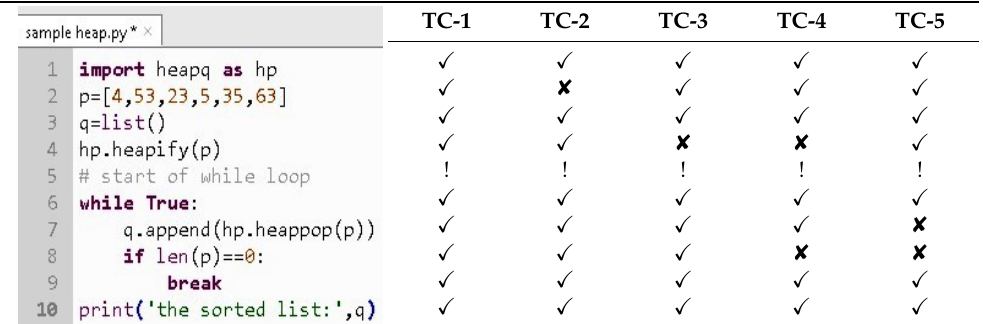
Table 3. Table representing the code snippet with the outcome of test cases.